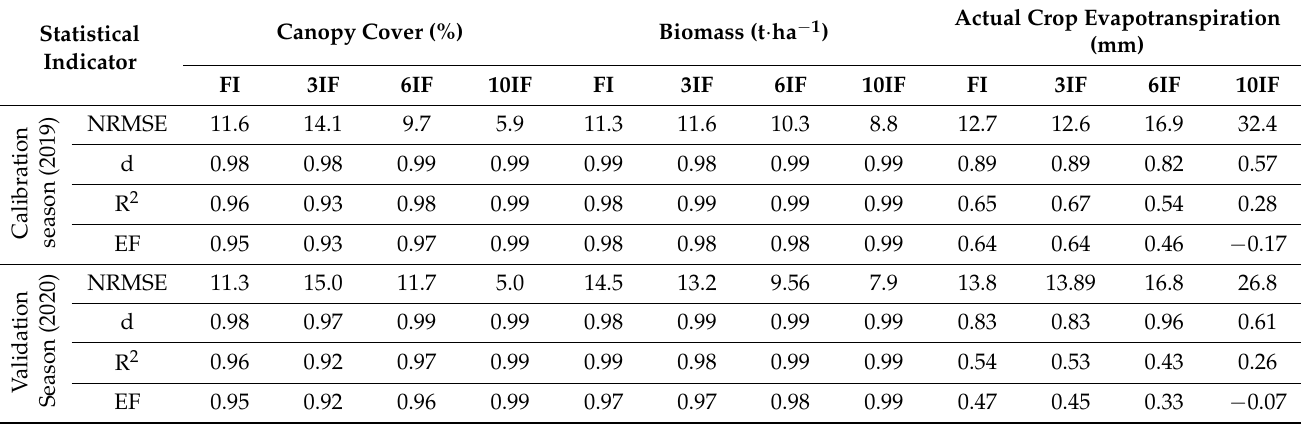
Figure 7. Observed and simulated average canopy cover during the validation period (2020) under four irrigation regimes. FI, flood irrigation ( a ); 3IF, 3-day irrigation frequency ( b ); 6IF, 6-day irrigation frequency ( c ); and 10IF, 10-day irrigation frequency ( d ). Error bars indicate standard deviation among the three replicates. Table 4. Statistical indicators in estimating canopy, biomass, and actual crop evapotranspiration during 2019 and